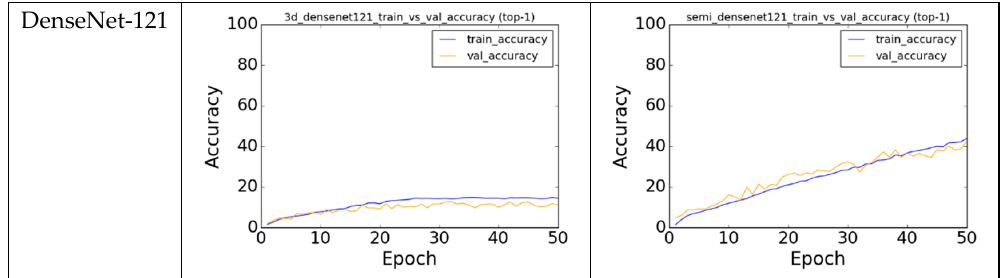
Figure 2. Performance plots for 3D-CNN and semi-CNN architectures applied on VGG, ResNet and DenseNet models.